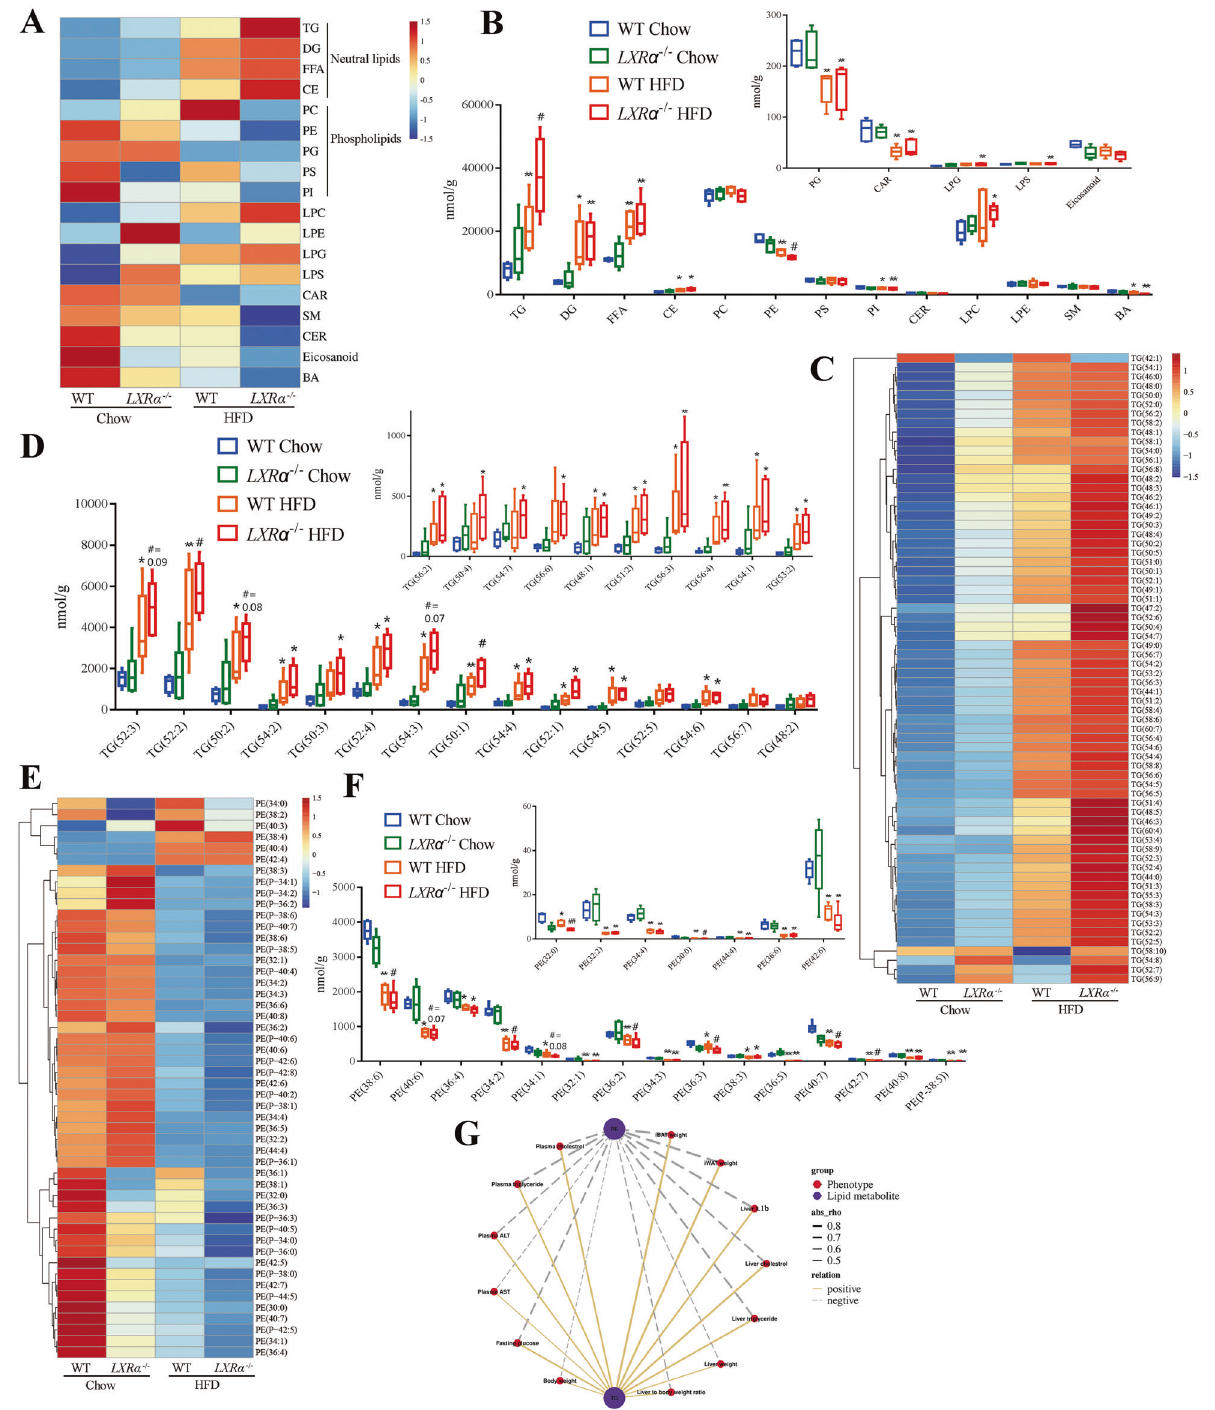
Fig. 3 LXR α de fi ciency exacerbates HFD-induced lipid disorders between TG and PE. A Heatmap of average levels of lipid species concentrations (nmol/g) in liver tissues ( n = 5). B Amount of lipid species in liver tissues illustrated as concentration (nmol/g) of each lipid species. Lipid species with very low concentrations are shown in the right corner of the panel ( n = 5). C Heatmap of species of TG containing different lengths of fatty acids based on the concentrations (nmol/g) in liver tissues. The increased TG species code the color as the red in the heatmap; the decreased ones code the blue ( n = 5). D Abundant and representative concentration (nmol/g) of TG containing different lengths of fatty acids in the liver tissues; TG species with very low concentration are shown in the right corner of the panel ( n = 5). E Heatmap of species of PE containing different lengths of fatty acids based on the concentrations (nmol/g) in liver tissues. The increased PE species code the color as red in the heatmap; the decreased ones code the blue ( n = 5). F Abundant and representative concentration (nmol/g) of PE containing different lengths of fatty acids in the liver tissues; PE species with very low concentration are shown in the right corner of the panel ( n = 5). * P < 0.05 and ** P < 0.01 were compared with WT Chow; # P < 0.05 was compared with WT HFD. G Correlation network among the mice phenotypes and the lipid metabolites of total TG and PE.